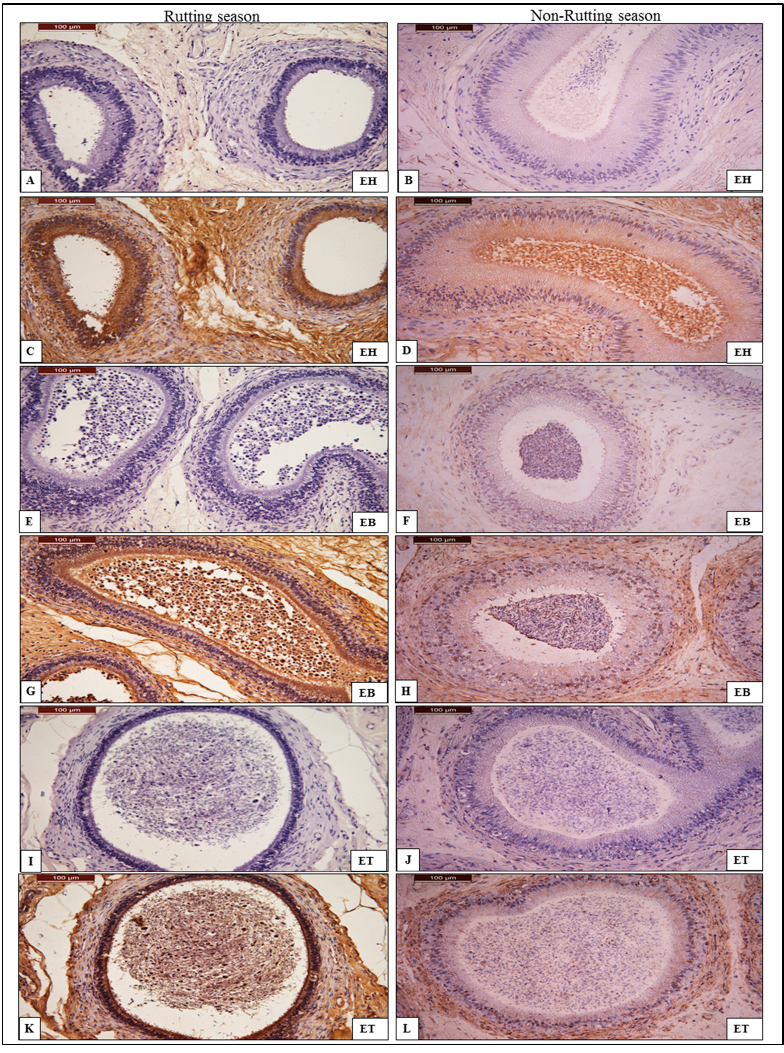
Figure 3. Chromogenic immunohistochemistry of anti-AQP-7 antibody in head (EH), body (EB) and tail (ET) of epididymis. ( A , E , I ): negative control of anti-AQP-7 antibody in EH, EB and ET during rutting season; ( C ) intensely positive reaction of AQP-7 in EH during rutting season shows strong positivity in basal cell (stem cell) layer and sterocelia of the columnar cell; ( G ) positive reaction of AQP-7 in EB during rutting season shows intense positivity of sterocelia of the columnar cell and ( K ) positive reaction of AQP-7 in ET during rutting season shows intense positivity of columnar cell. ( B , F , J ): negative control of AQP-7 in EH, EB and ET during non-rutting season; ( D,H , L ) are positive reactions of AQP-7 in EH, EB and ET during non-rutting season, which shows very weak positivity in both the basal cell and columnar cell. AQP-7 is stained by DAB/chromogen and counter-stained with hematoxylin under magnification power 40×.